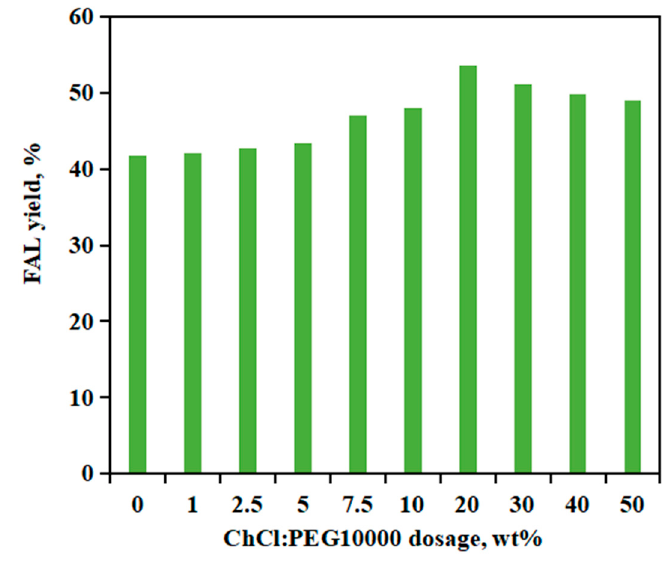
Figure 5. Effects of ChCl:PEG10000 load (0–50 wt%) on the FAL formation (corn stover 75 g/L, solid acid 1.2 wt%, 170 °C, 30 min).